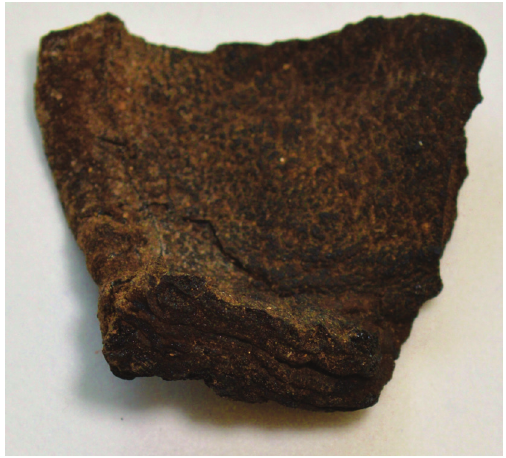
Figure 2 Fragment of multi-layered leather bookbinding, with a clear corner and a thin edging strip forming two finished edges (Source: photograph by Paulina